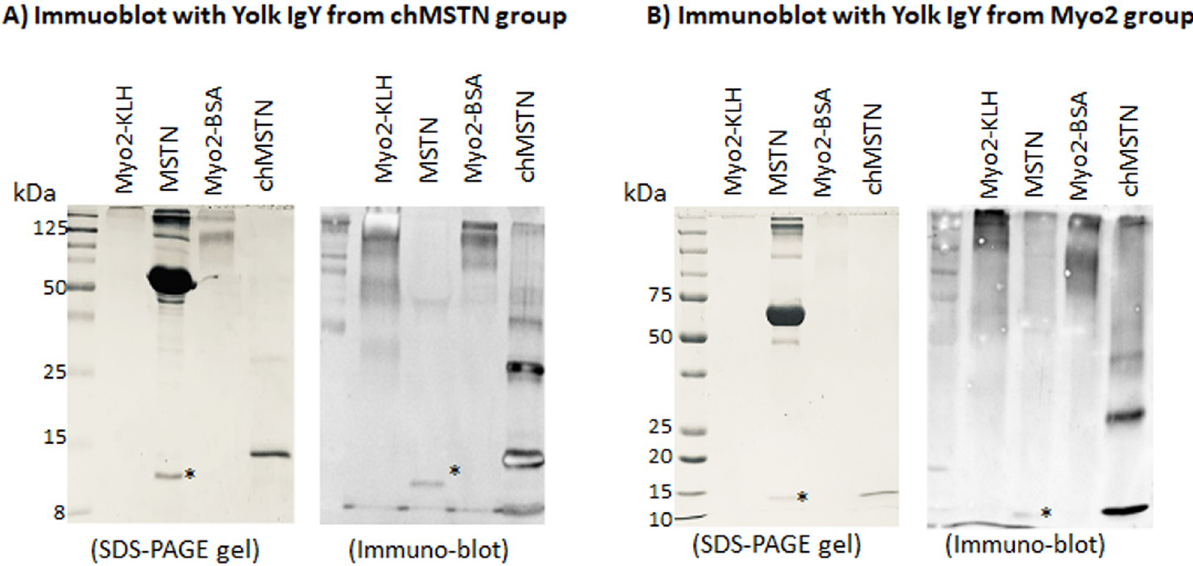
Fig 5. Western blot analysis of binding characteristics of egg yolk IgY from the chMSTN and Myo2 groups. 400 ng of Myo2-KLH, Myo2-BSA, chMSTN, and 200 ng of MSTN with BSA as a carrier protein were subjected to SDS-PAGE, and Western blot was performed using 1:200 dilution of egg yolk IgY (2.1 mg/mL) from the chMSTN group (A) or the Myo2 group (B) as a primary antibody, 1:10,000 diluted HRP conjugated anti-chicken IgY as a secondary antibody, and luminescence substrate for signal detection. The asterisks indicate MSTN